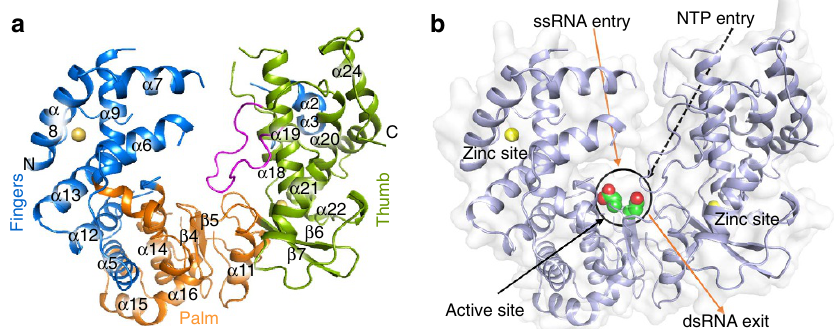
Figure 1 | Crystal structure of Zika virus NS5 RdRp. ( a ) ZIKV NS5 RdRp structure with fingers, palm and thumb domains coloured in blue, orange and green, respectively. The priming loop is depicted in pink. ( b ) Surface view of the ZIKV NS5 RdRp, with orange arrows pointing the entry of the single-strand RNA template, and the exit region of the double-strand RNA. Catalytic aspartates are depicted as green/red spheres. Black dashed arrow shows the entry path of NTPs, while black arrow point to the position of the active site. In both figures, zinc atoms are depicted in yellow.